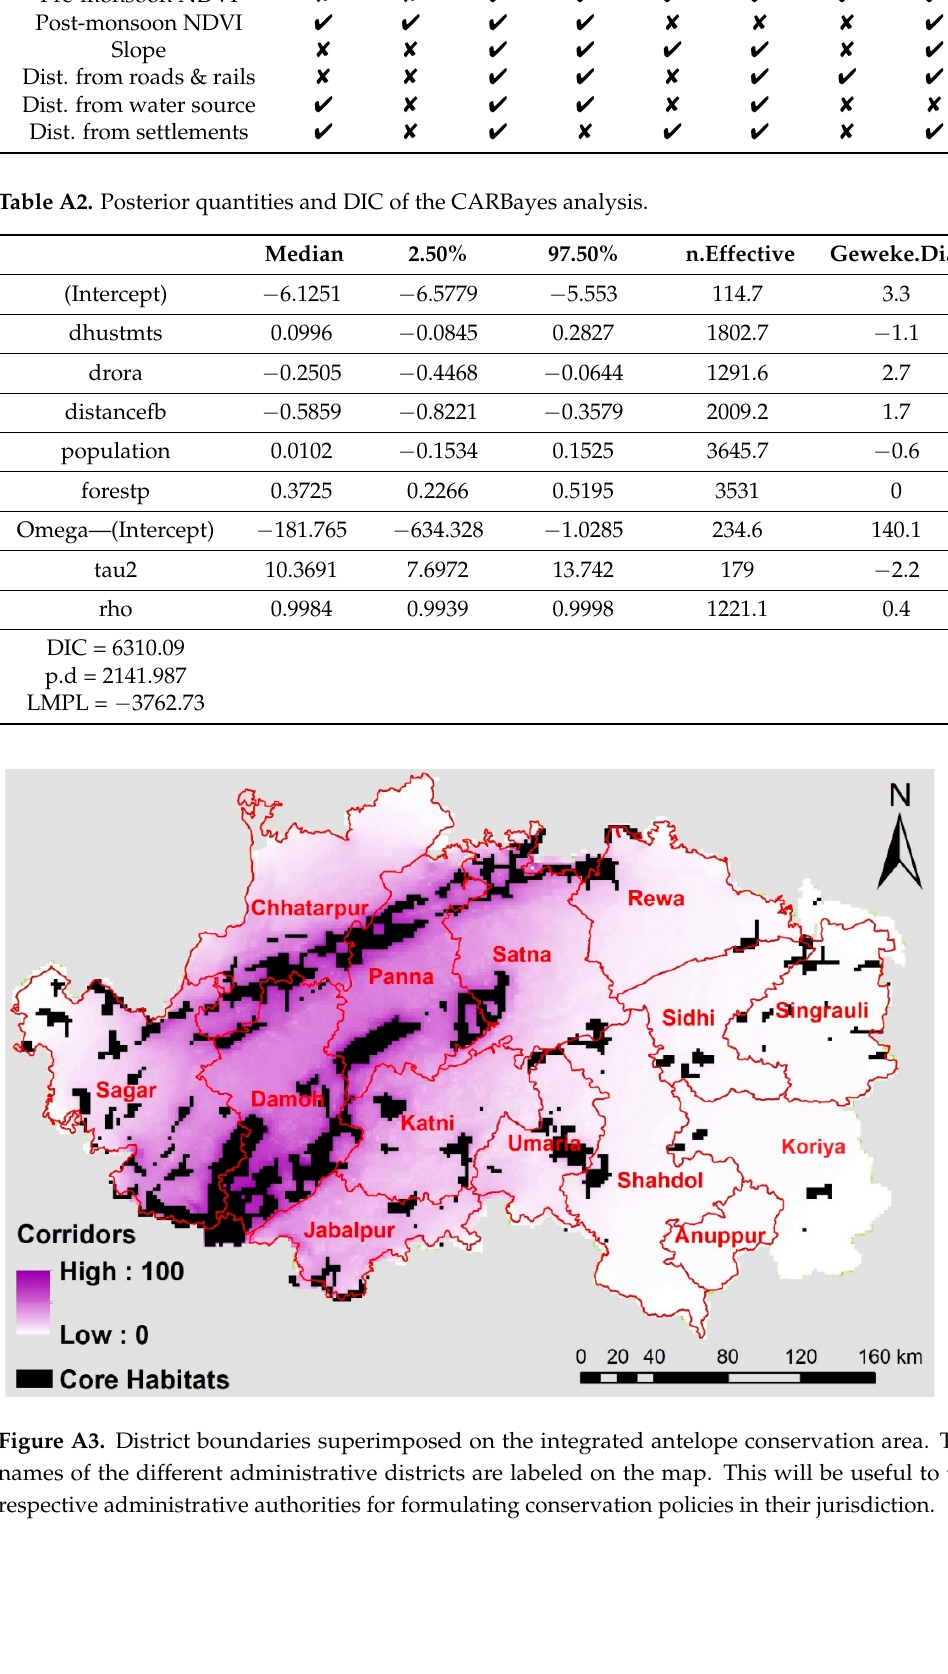
Table A1. Variables found significant ( ✓ ) and not significant ( ✗ ) for habitat suitability modeling of the four focal antelope species.